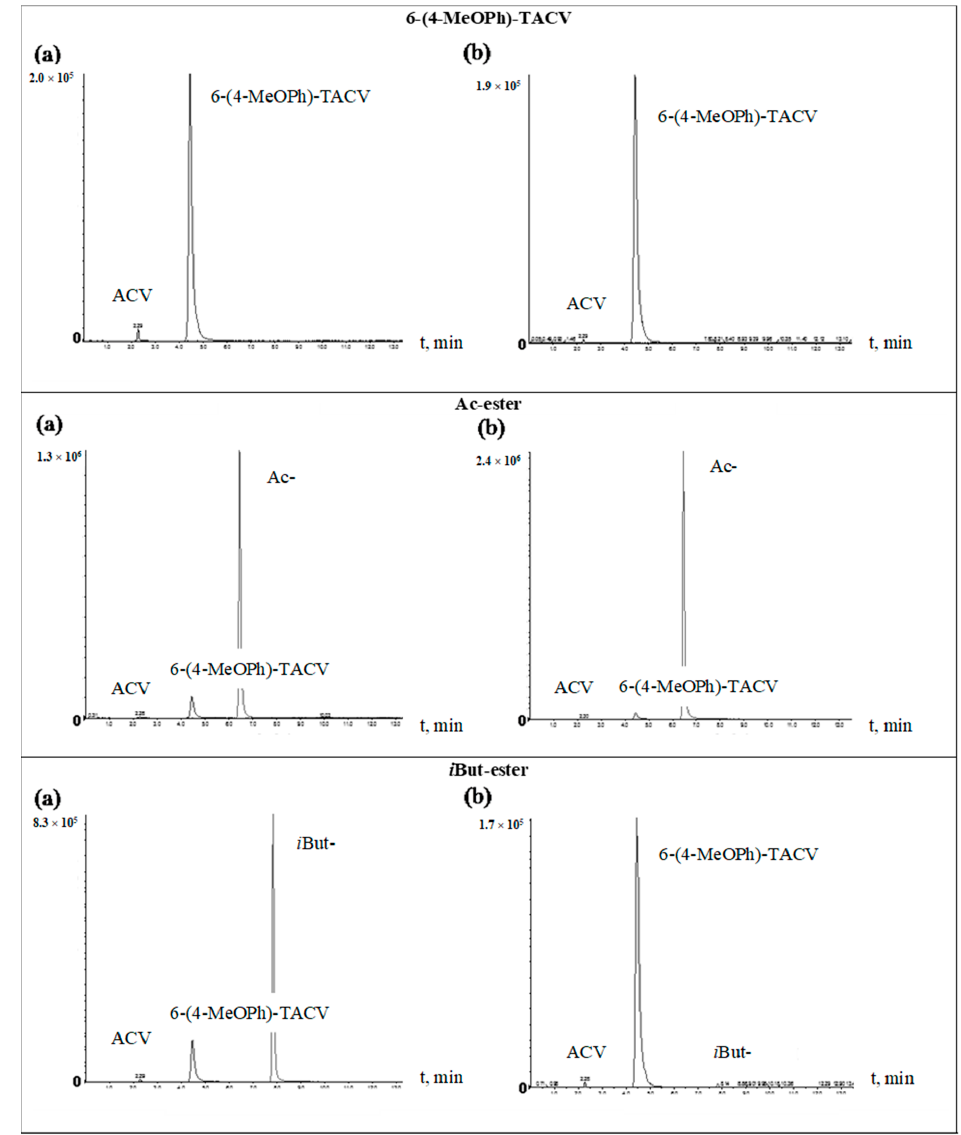
Figure 5. HPLC-MS/MS chromatograms of test compounds: 6-(4-MeOPh)-TACV and its Ac- and i But esters hydrolyzed at 37 °C. ( a ) in plasma (80%) for 24 h; ( b ) in plasma (80%) in the presence of porcine esterase (5.50 · 10 − 9 M) for 2 h.